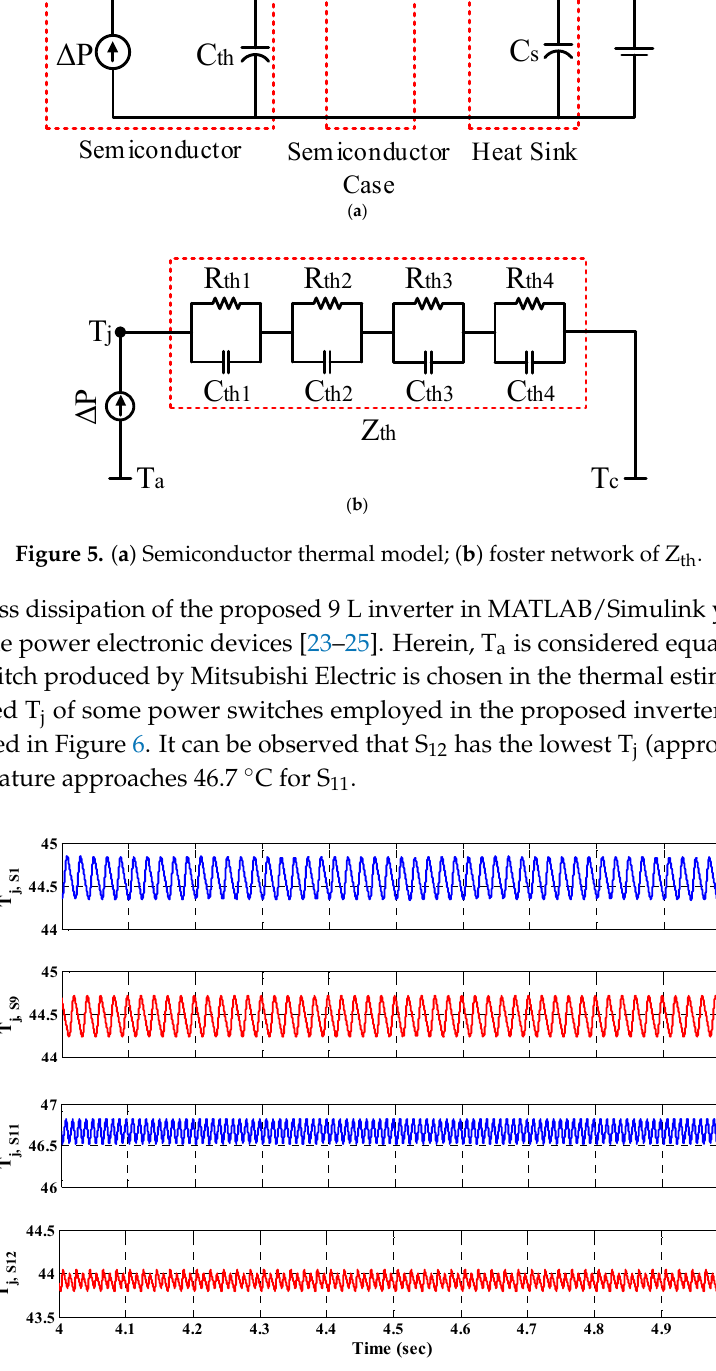
Figure 6. The estimated T j at 20 kW output power.